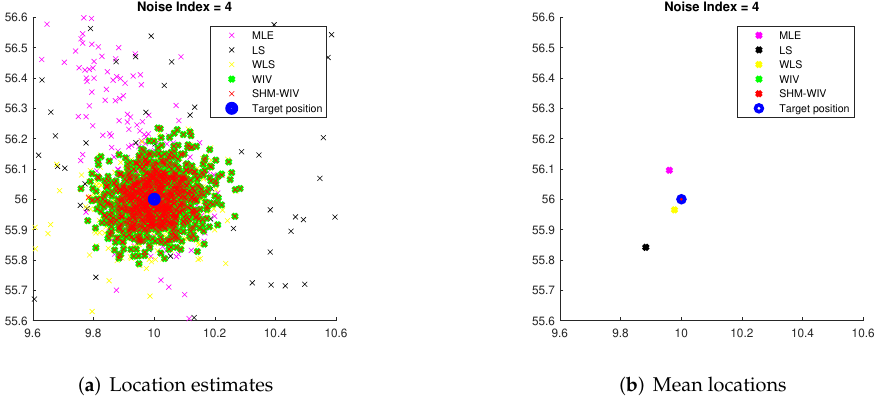
Figure 7. ( a ) Plot of individual location estimates for noise index 4; ( b ) Plot of mean location estimates for noise index